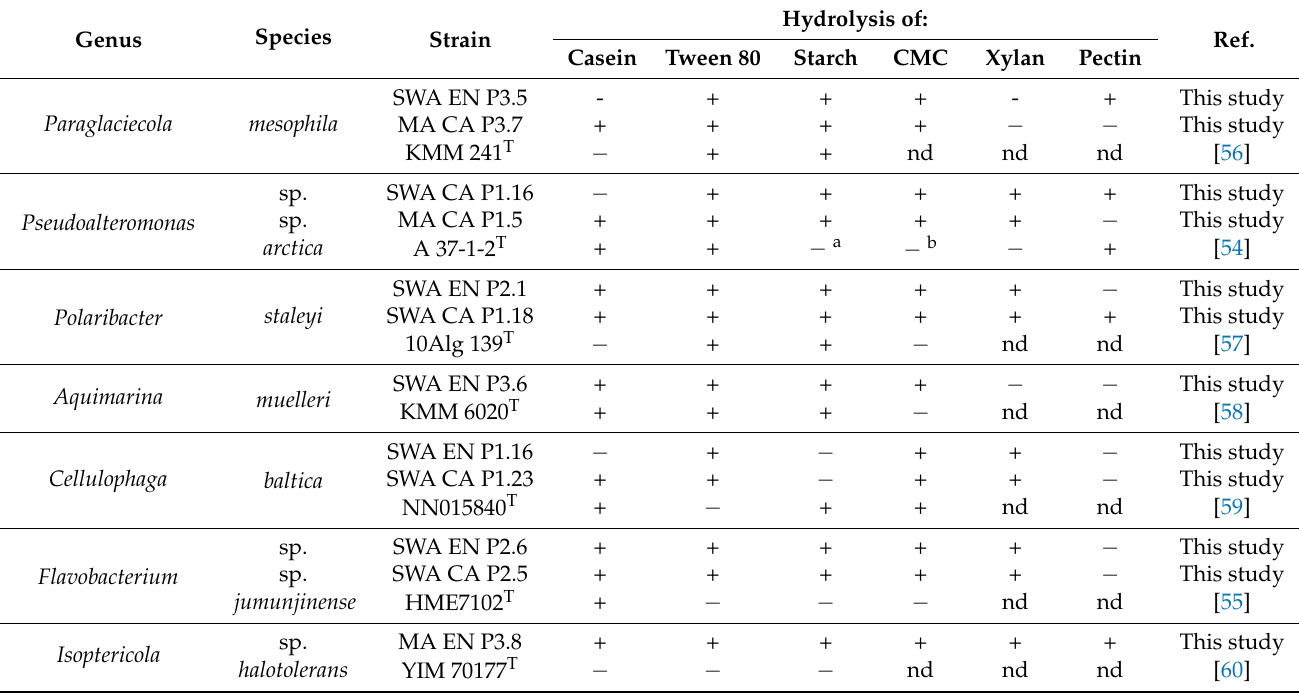
Table 3. Extracellular hydrolytic activities of some of the bacterial strains isolated in the present study and of the related type strains 1